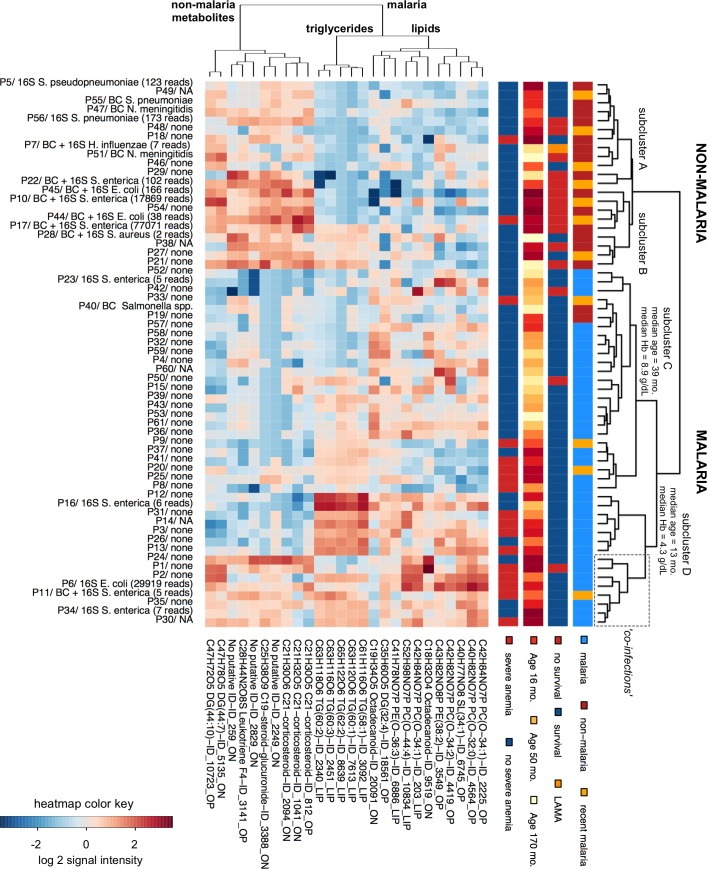
Heatmap of the top 26 features that characterize non-malaria and malaria febrile illness.Patients are shown along the y-axis, the four color-coded bars right of the heatmap indicate their malaria status, survival outcome, age and severe anemia status. The annotation right of the heatmap shows which pathogenic bacteria were identified by blood culture (BC) and/or by 16S sequencing (16S) along with the pathogen species detected (in case of 16S results, only the most abundant pathogen is shown with the matching number of sequencing reads); NA = incomplete BSI diagnosis. The 26 metabolites are shown along the x-axis, their putative identity and feature ID as listed in S1 data are shown below the heatmap. Unsupervised hierarchical clustering of the patients (the tree right of the y-axis) reveals that the shown metabolite intensity profiles differ sufficiently to distinguish non-malaria (upper branch) and malaria patients (lower branch). Clustering of the metabolites according to similarity in intensity profiles (the tree above the x-axis) reveals 3 major groups of metabolite features: the right cluster are plasma phospholipids and fatty acids typically appearing in malaria patients, the middle cluster are the malaria triglycerides, and the left cluster are metabolites characteristic for non-malaria febrile illness. (Abbreviations: LAMA = left against medical advice, mo. = months, Hb = hemoglobin, lipids are abbreviated with PC, PE, SL, DG or TG for phosphatidylcholines, phosphatidylethanolamines, sphingolipids, diacylglycerides and triacylglycerides respectively, and the total number of acyl side-chain carbons and the double bonds in the side-chains.)